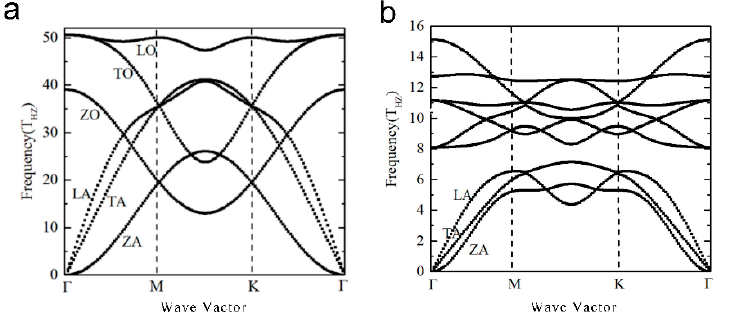
Figure 7. ( a ) Phonon spectra of monolayer graphene, ( b ) monolayer MoS 2 . Reproduced from [101], with the permission of the MDPI.